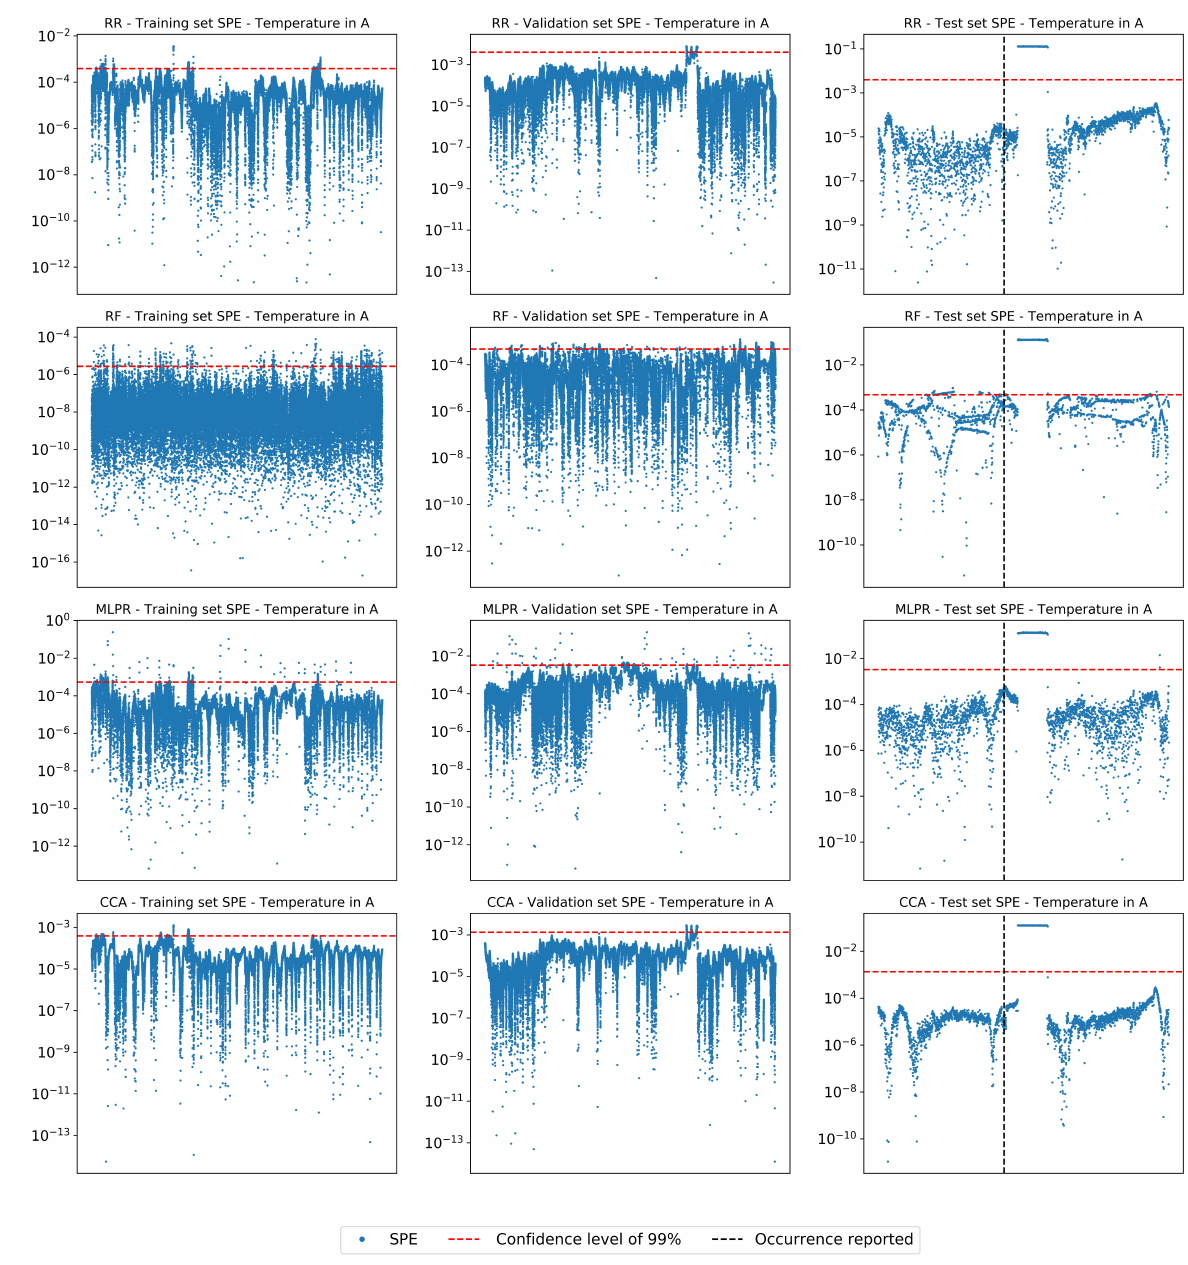
Figure 7. Fault detection index SPE along Fault-FIII when the PCStable algorithm (partial correlation) with MCI (conditional mutual information) was used as the variable selection